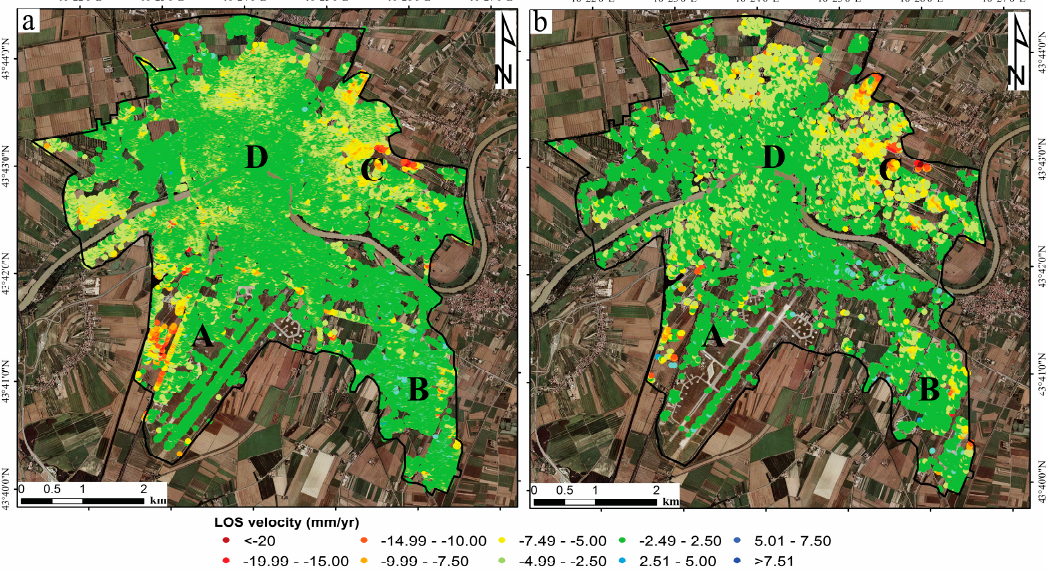
Figure 3. Registered Line of Sight (LOS) velocities between 2011 and 2014. ( a ) COSMO-SkyMed data; ( b ) RADARSAT-2 data. Deformation maps are overlaid on a 2000 digital orthophoto. The black line encloses the investigated area. (A) Galileo Galilei International Airport; (B) Ospedaletto district; (C) Cisanello–San Cataldo–La Fontina district; (D) inner city area.